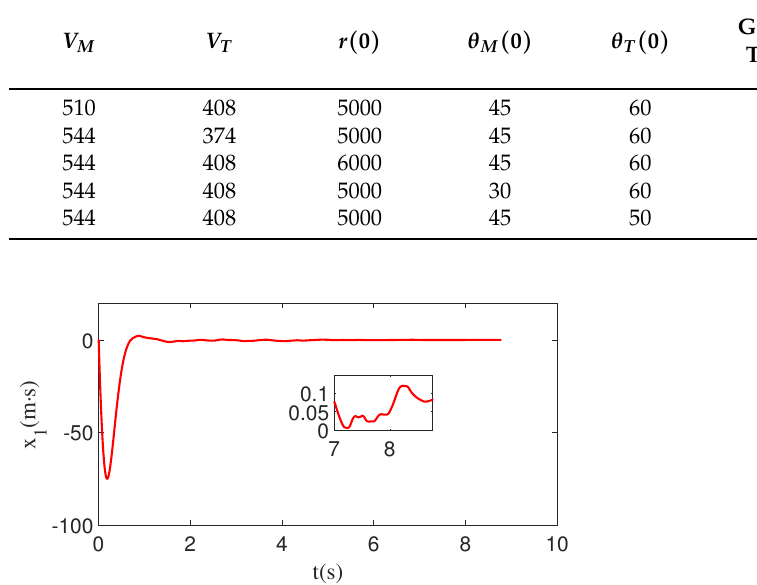
Figure 9. The change of the integral of ZEM with white noise and constant maneuver.